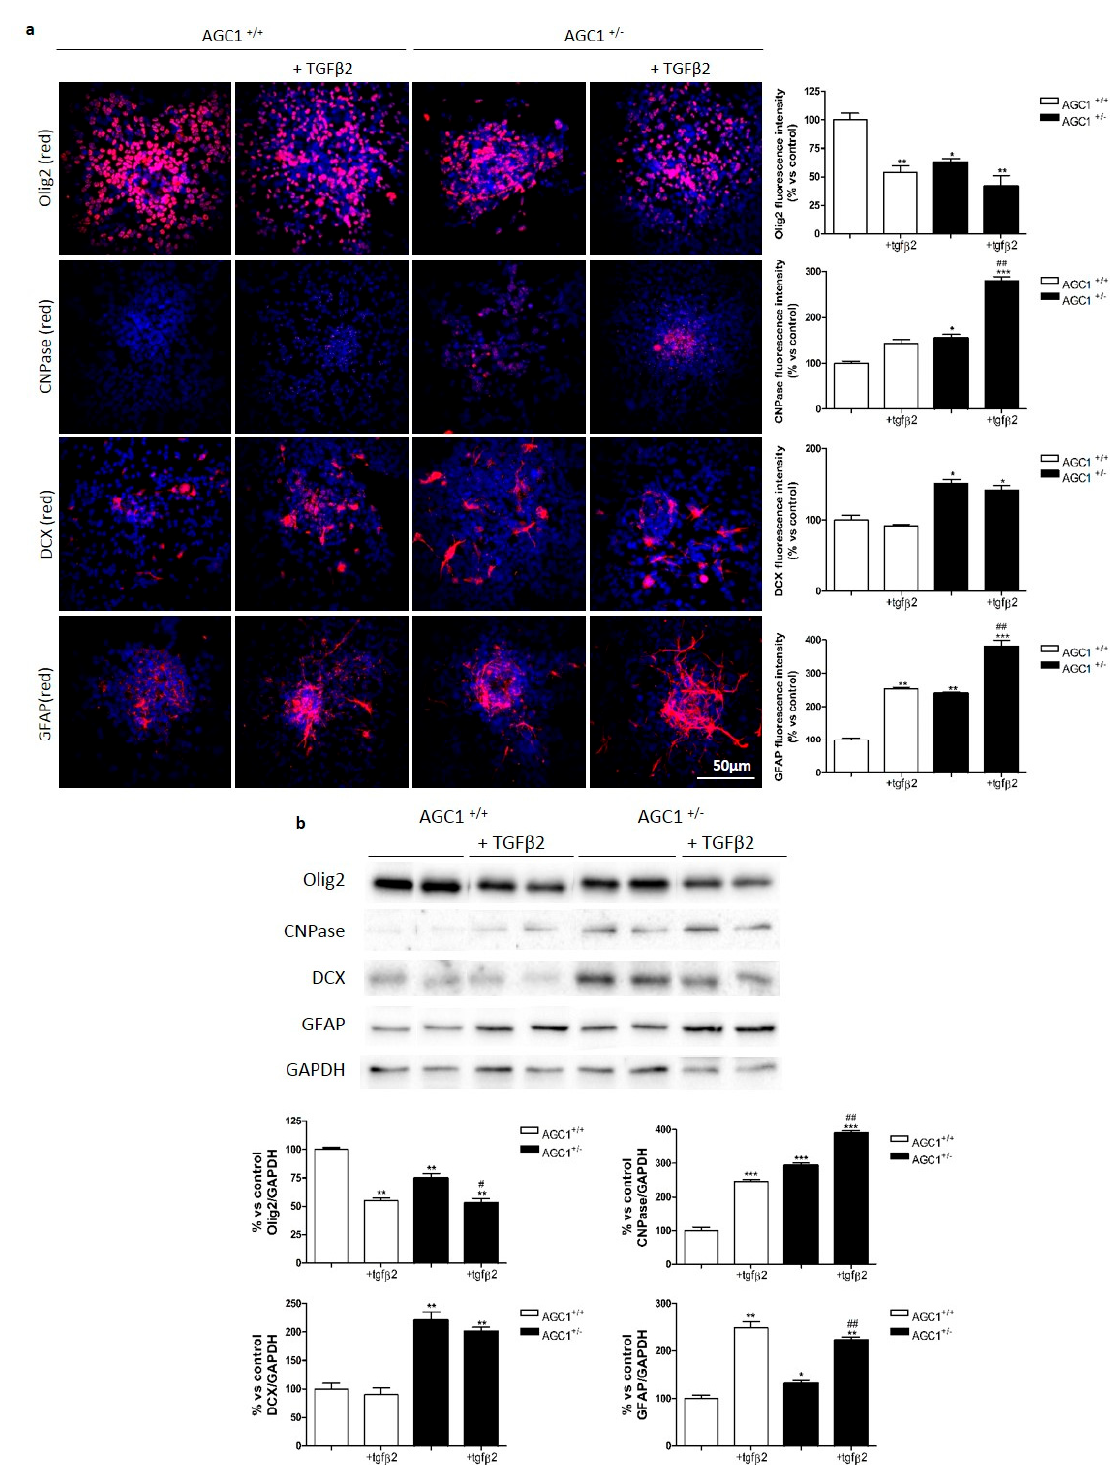
Figure 7. Effect of exogenous TGF β 2 on proliferation/differentiation in neurospheres from AGC1 +/+ and AGC1 +/ − mouse SVZ. Immunofluorescence staining in AGC1 +/+ and AGC1 +/ − neurospheres and following treatment with TGF β 2 after 4-day differentiation ( a ). Olig2, CNPase, DCX and GFAP used as specific markers for OPCs, mature oligodendrocytes, NSCs and astrocytes respectively (nuclei labelled with Hoechst). Scale bar: 50 μ m. Analyses for Olig2 + and DCX + cell number and CNPase + /GFAP + fluorescence signal intensity evaluated with Fiji ImageJ2 software. Values are the mean ± SE of 3 independent experiments performed in triplicate, * p < 0.05, ** p < 0.01, *** p < 0.001 compared to control AGC1 +/+ neurospheres, # p < 0.05, ## p < 0.01 compared to control AGC1 +/ − neurospheres, Two-way ANOVA (Bonferroni’s post-test). Western blot analysis and relative